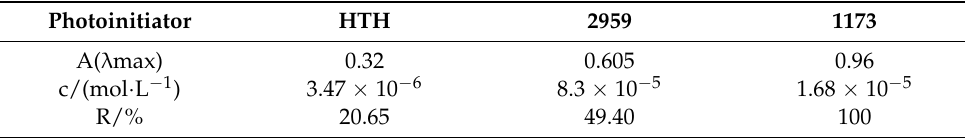
Figure 10. UV-Vis absorption spectra of extraction solutions from 1173, 2959, and HTH. Table 3. The migration of HTH, 2959 relative to